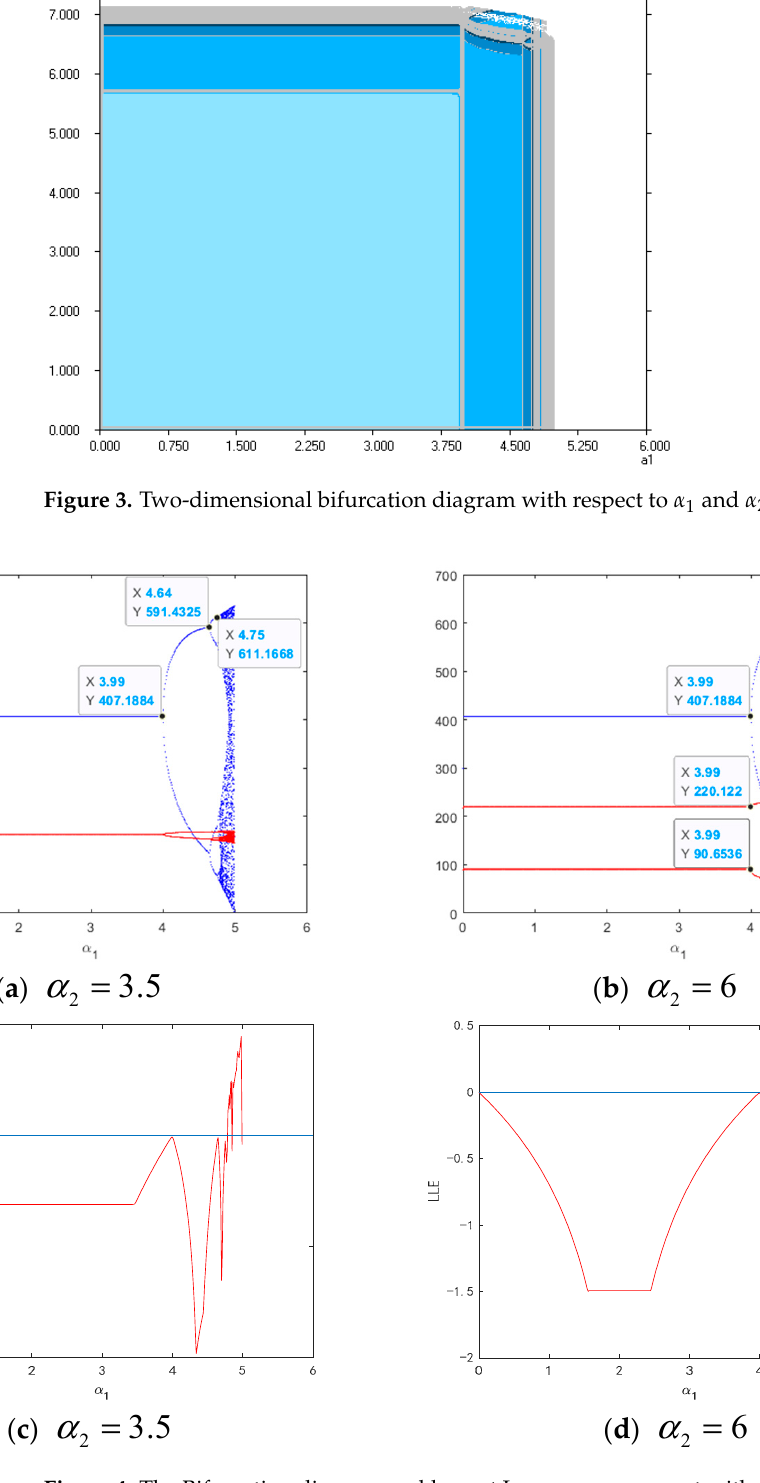
Figure 4. The Bifurcation diagram and largest Lyapunov exponent with respect to α 1